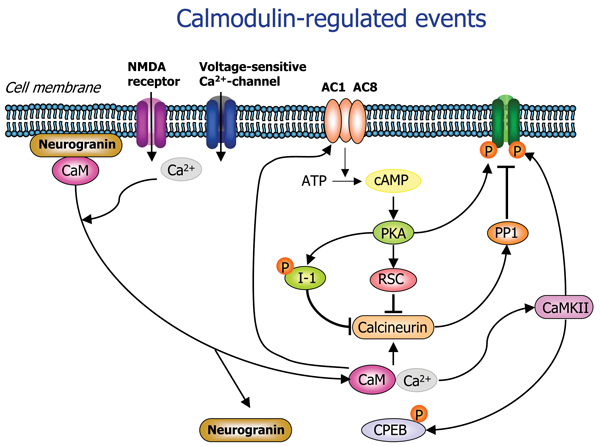
Calcium-calmodulin network. Ca2+-signaling is mediated through several Ca2+-binding proteins, including calmodulin (CaM) and protein kinase C (PKC). The activity of N-methyl-d-aspartate (NMDA) receptors or voltage-sensitive Ca2+ channels leads to an increase in intracellular Ca2+, which triggers a release of calmodulin that was previously bound to neuromodulin or neurogranin. Depending on Ca2+, CaM modulates the activity of several key signaling molecules that are crucial for synaptic plasticity including adenylyl cyclases (AC), protein kinases, calcineurin, nitric oxide synthase, Ca2+-channels, ATP-dependent Ca2+-pumps, and the CaM-dependent protein kinases (CaMKII). CaM has four Ca2+ binding sites and in the presence of CaM binding protein, it shows heterotropic positive cooperativity for Ca2+. This enables that CaM-regulated AC and cyclic nucleotide phosphodiesterases have different Ca2+-sensitivities, and that CaM-stimulated phosphatase calcineurin has greater sensitivity to Ca2+ than CaMKII.